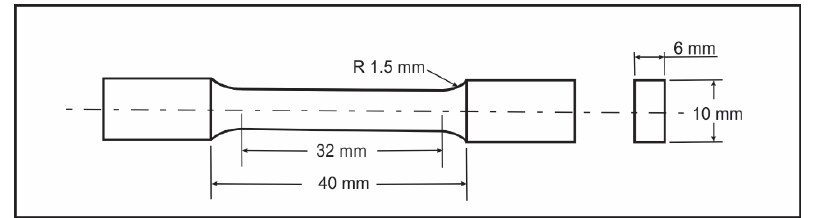
Figure 2. Geometry and dimensions of the tension specimen according to ASTM E8 Standards [20]. Table 3. Parameters of the tensile specimens.